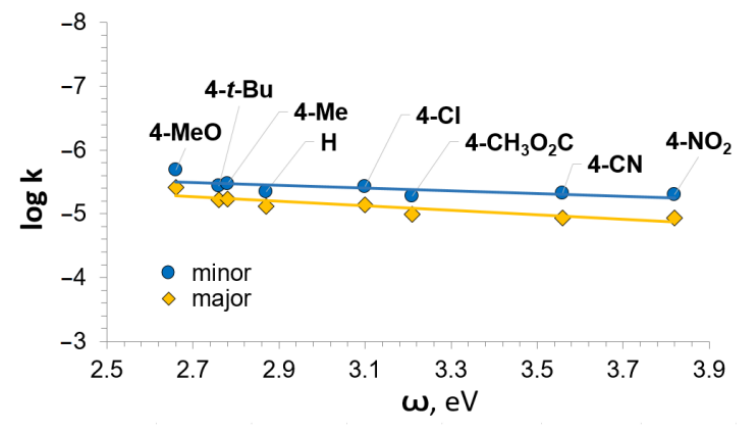
Figure 3. Plot of log k versus electrophilicity indexes (ω).